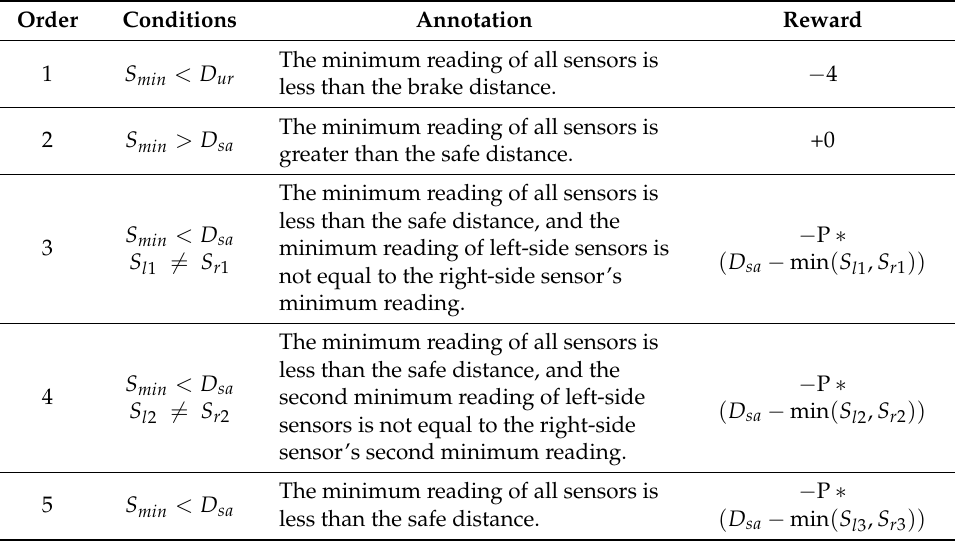
Table 2. Comparative value reward in obstacle-avoiding